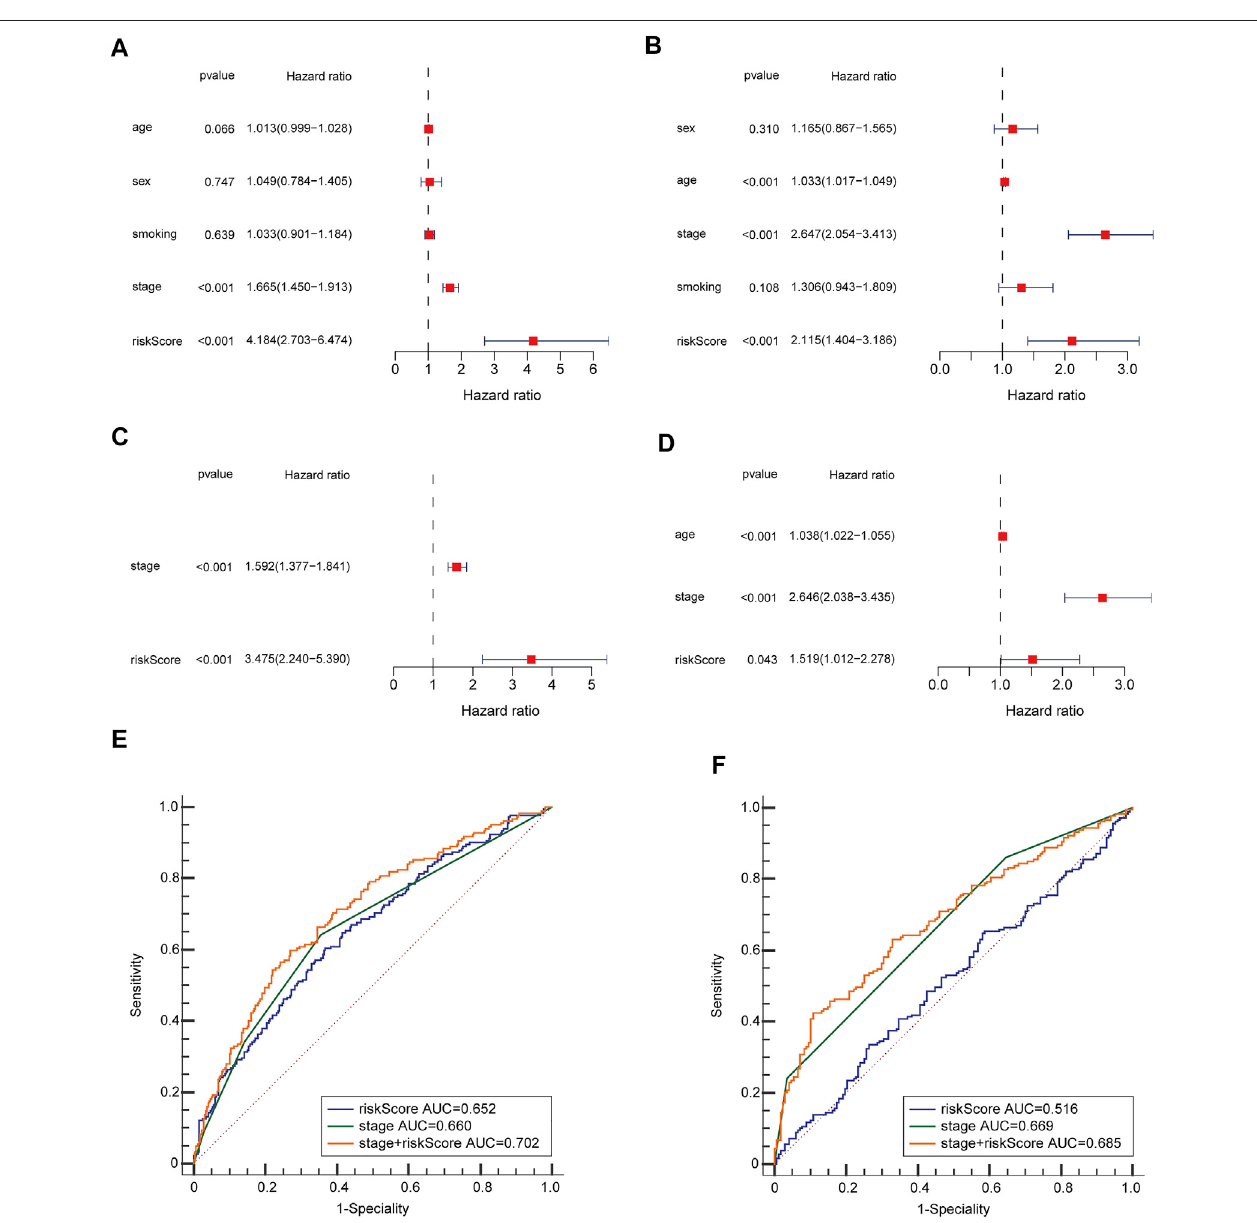
FIGURE 4 | OS-related factors were screened, and the prognostic accuracy of risk score and clinicopathological factors were compared. TCGA cohort (A,C,E) , GEO cohort (B,D,F) . (A,B) OS-related factors were screened by Univariate Cox regression analyses. (C,D) OS-related factors were screened by Multivariate Cox regression analysis. (E,F) Time-dependent ROCcurvewas used to compare the prognostic accuracy of riskscore, tumor stage, and the combination ofrisk score. and tumor stage in 3-year.